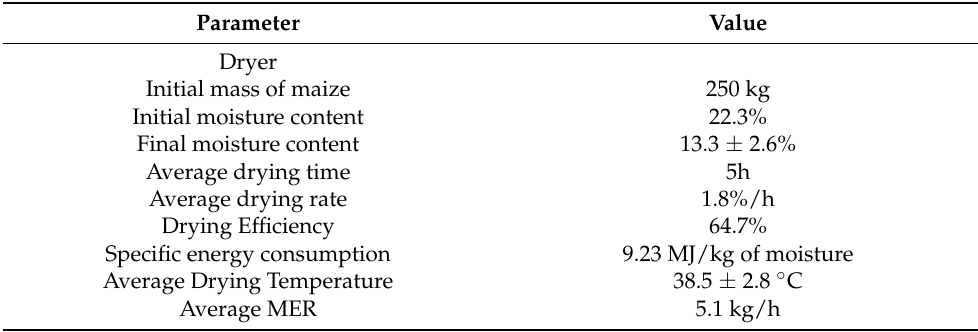
Table 1. Summary of dryer technical